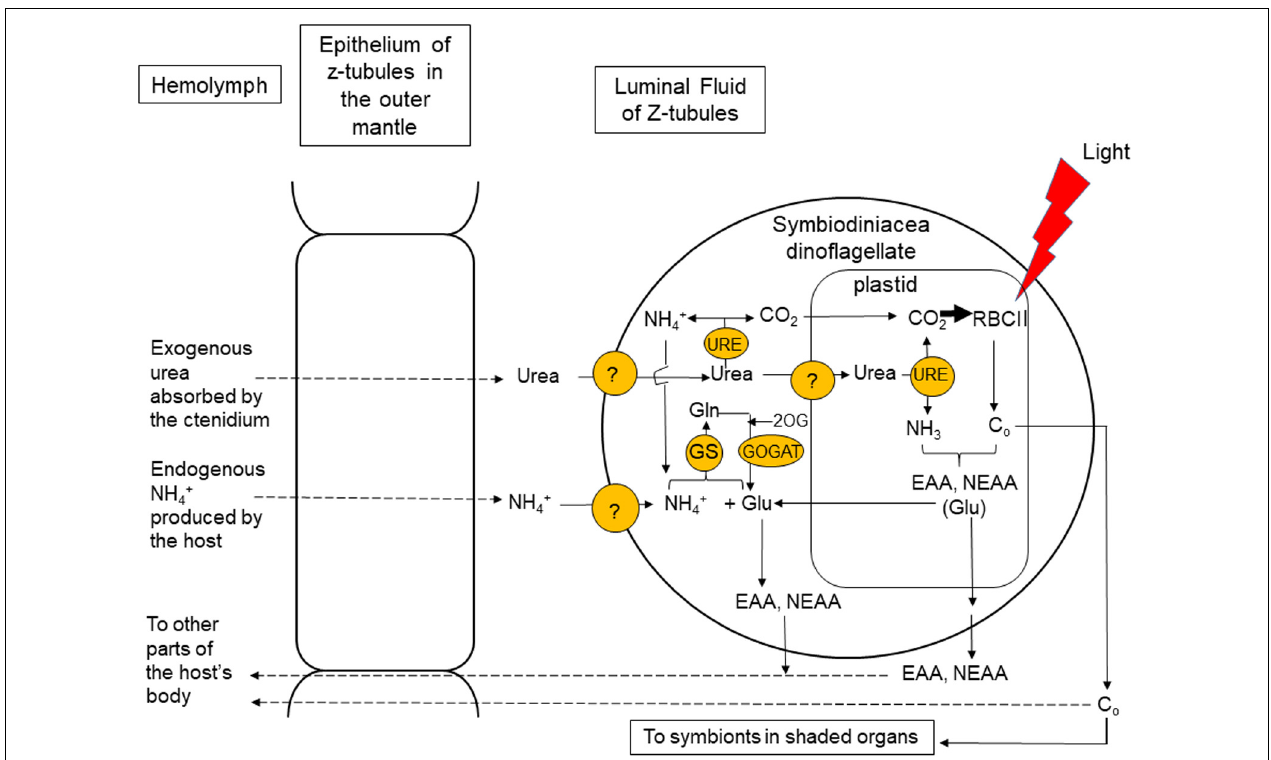
FIGURE 2 | Coupling of photosynthesis and nitrogen (N) assimilation leading to amino acid synthesis in the symbiotic dinoflagellates residing in the colorful outer mantle of T. squamosa . Urea is a good source of N and CO 2 for symbiotic dinoflagellates, which possess urease (URE) to catalyze the degradation of urea. URE is localized in the plastid, where it can facilitate the effective harness of urea-carbon and urea-N for photosynthesis and amino acid synthesis, respectively (Ip et al., 2020b). URE is also localized in the dinoflagellates’ cytoplasm, where it can degrade some of the absorbed urea to ammonia. The ammonia (NH 4 + ) released and glutamate (Glu) can be utilized by the cytosolic Glutamine Synthetase (GS) to synthesize glutamine (Gln), which plays a central role in the syntheses of nucleic acids. Glu can be replenished by a reaction catalyzed by Glutamine 2-Oxoglutarate Amidotransferase (GOGAT), which utilizes Gln and 2-oxoglutarate (2OG) as substrates (Fam et al., 2018). With the GS:GOGAT cycle, symbiotic dinoflagellates can absorb and metabolize NH 4 + generated endogenously by the host to produce Glu, which can be used for amino acid synthesis. Symbiotic dinoflagellates need to supply the host with essential amino acids (EAA) and non-essential amino acids (NEAA) for its growth and development. C o , organic carbon. Z-tubule, zooxanthellal tubule. ?: unidentified transporters.